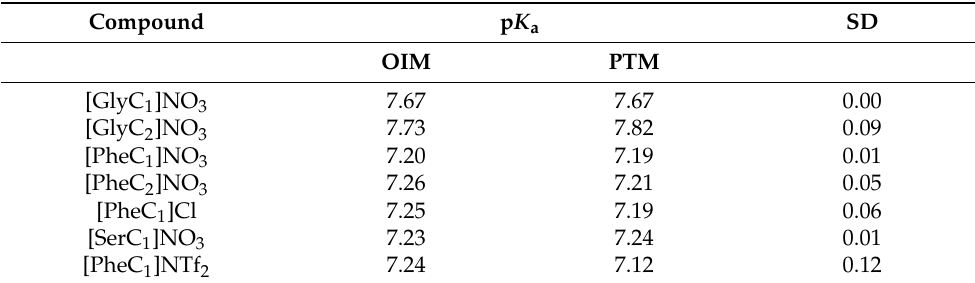
Table 3. The p K a values of a part of [AAE]X by the overlapping indicator method (OIM) and potential titration method (PTM).